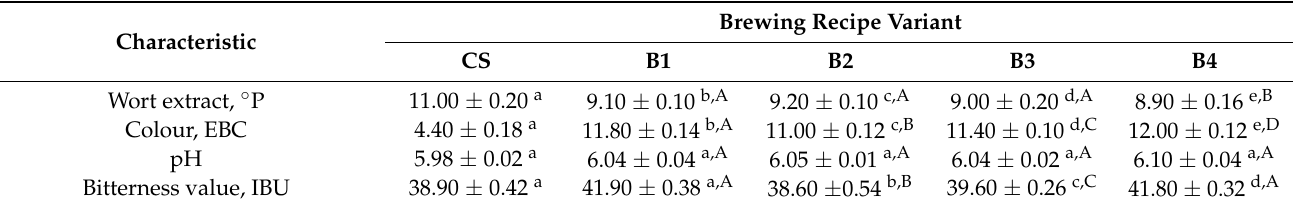
Table 7. Physico-chemical properties of wort after boiling.